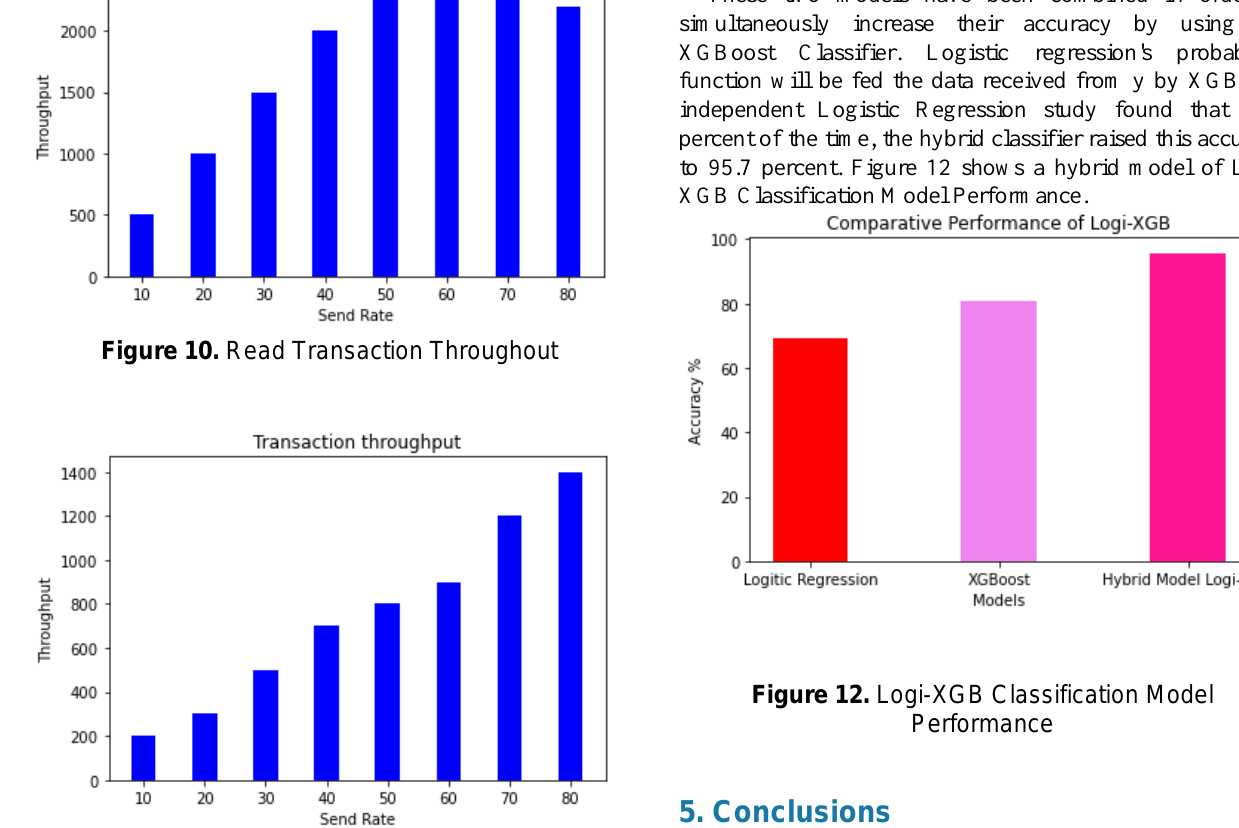
Figure 11. Transaction Throughout